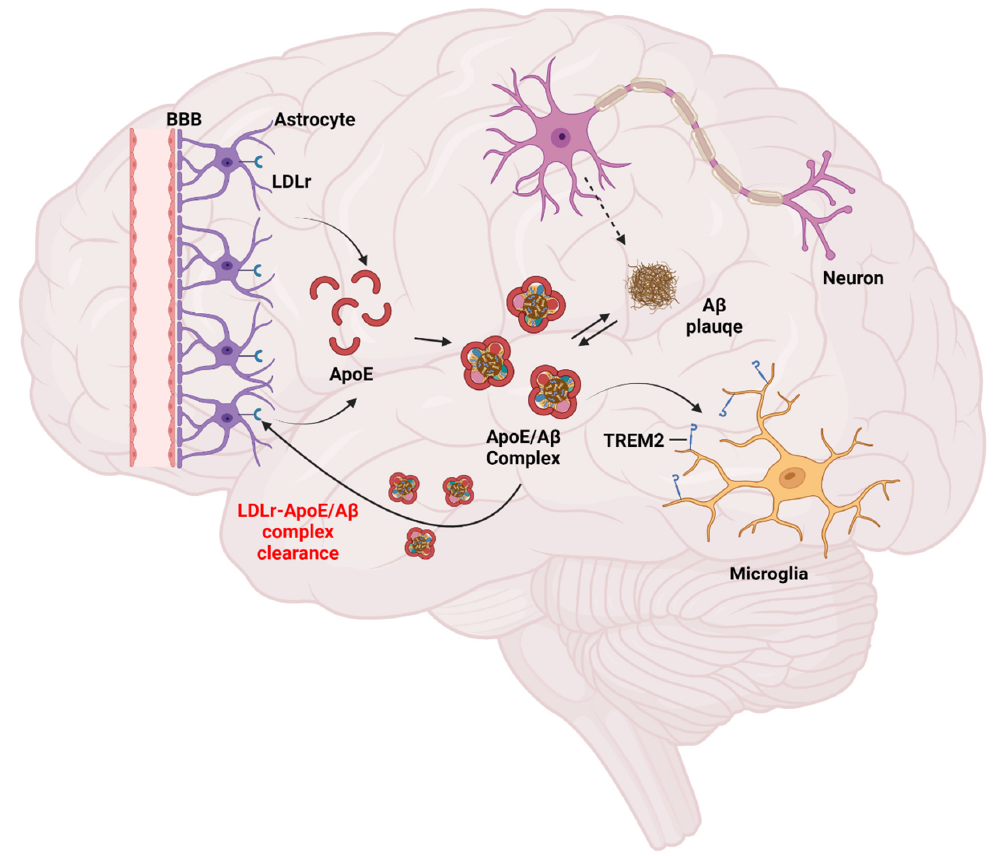
Figure 4. The process of the clearance of ApoE /A β complexes by LDLr .